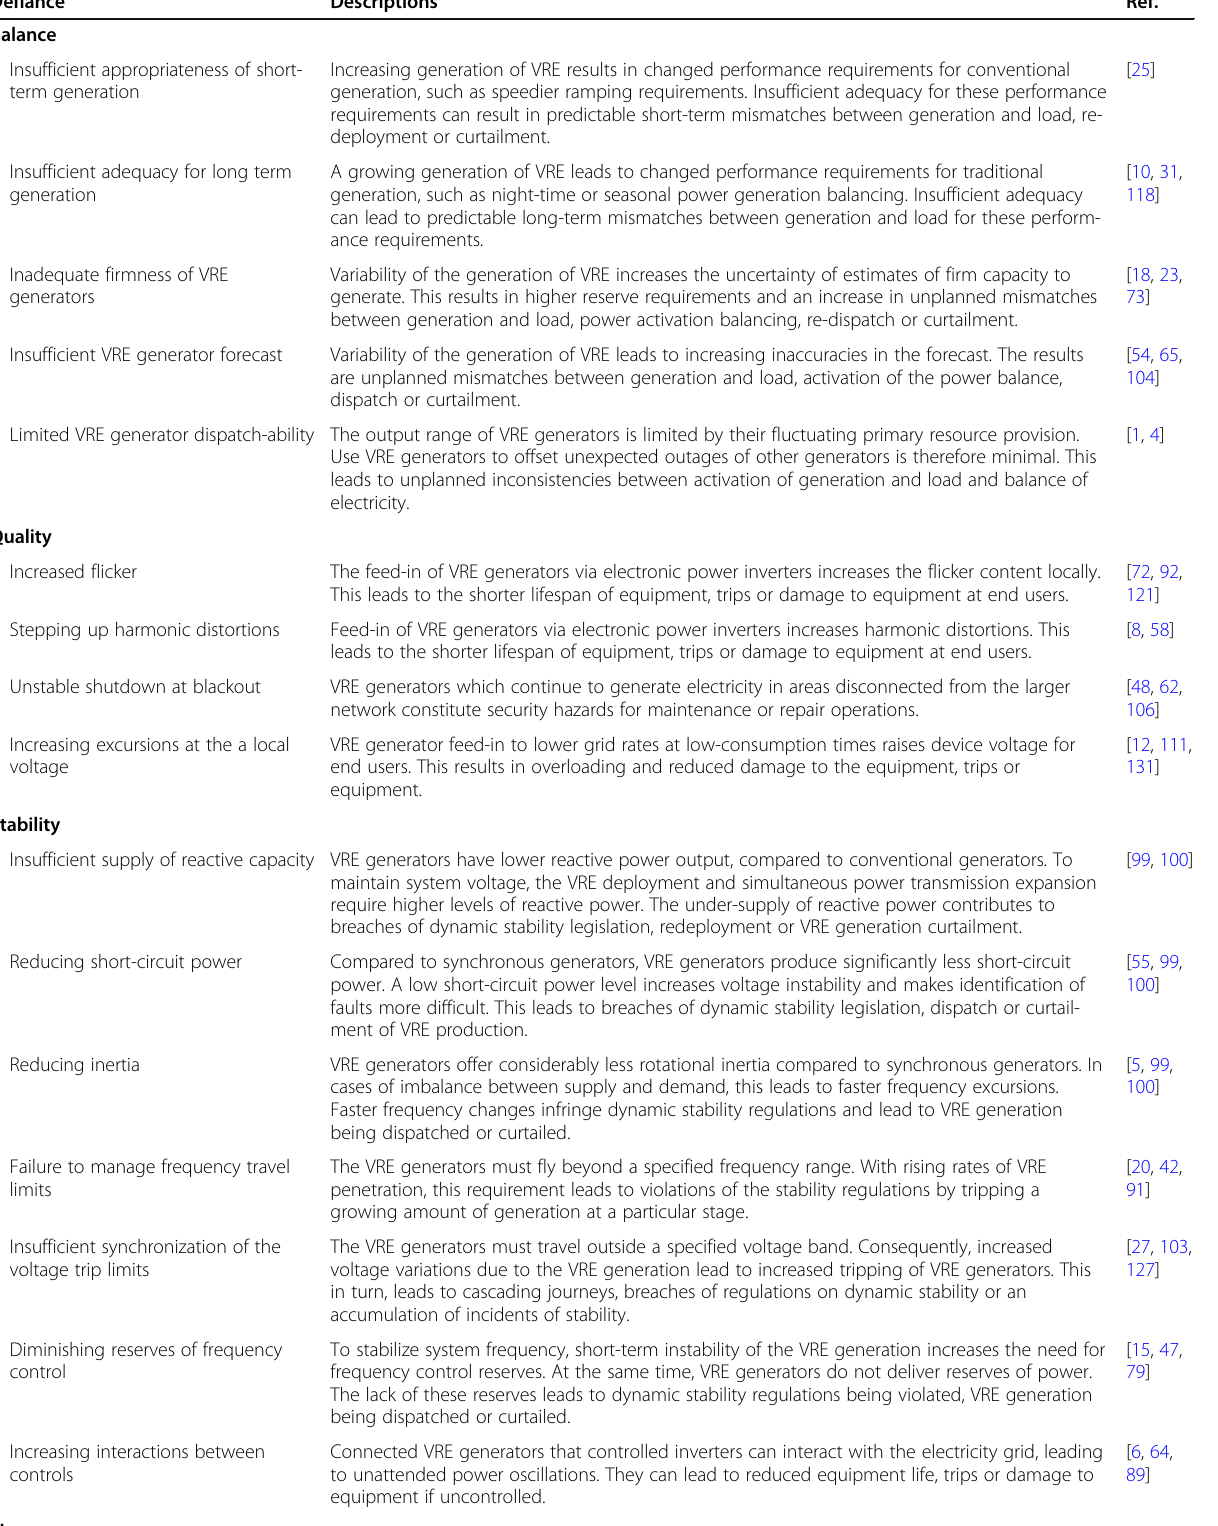
Table 3 Result of VRE Implementation